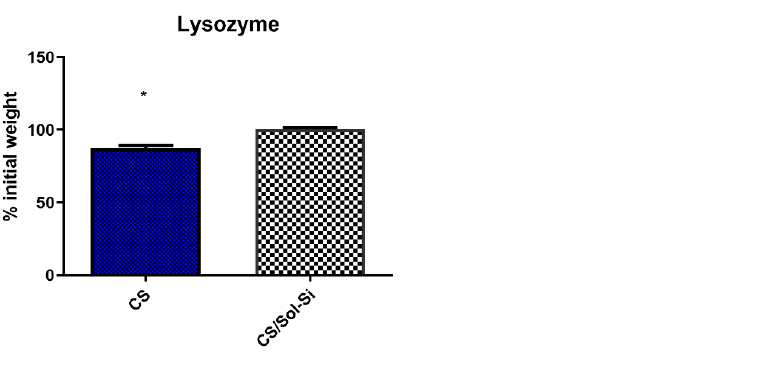
Figure 5. Biodegradation of CS and CS/Si-Sol biocomposite over 6 days with 1 mg/mL of lysozyme in PBS buffer, * ( p < 0.05) according to Student’s t -test.